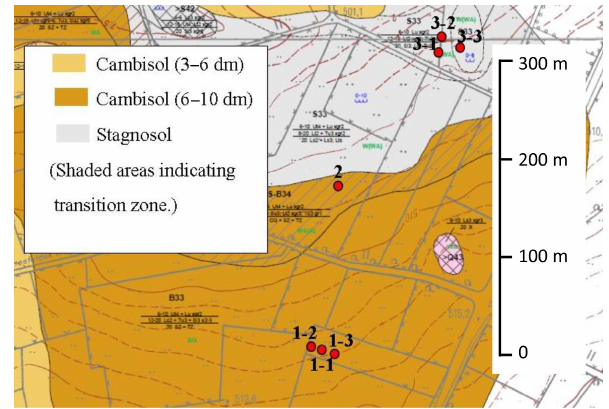
Figure 1. Excerpt from the soil map of the test site at Rollesbroich (modified from Geologischer Dienst Nordrhein-Westfalen, 2008). Numbered red dots indicate location of